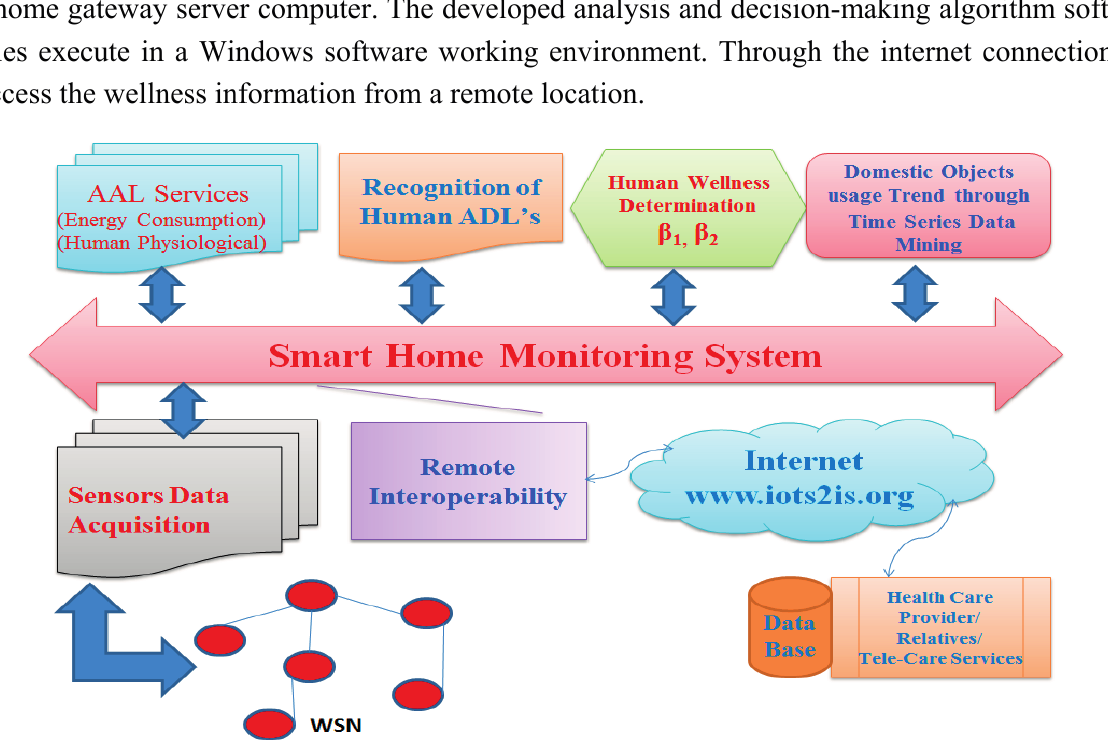
Figure 8. Functional description of the developed smart home monitoring system